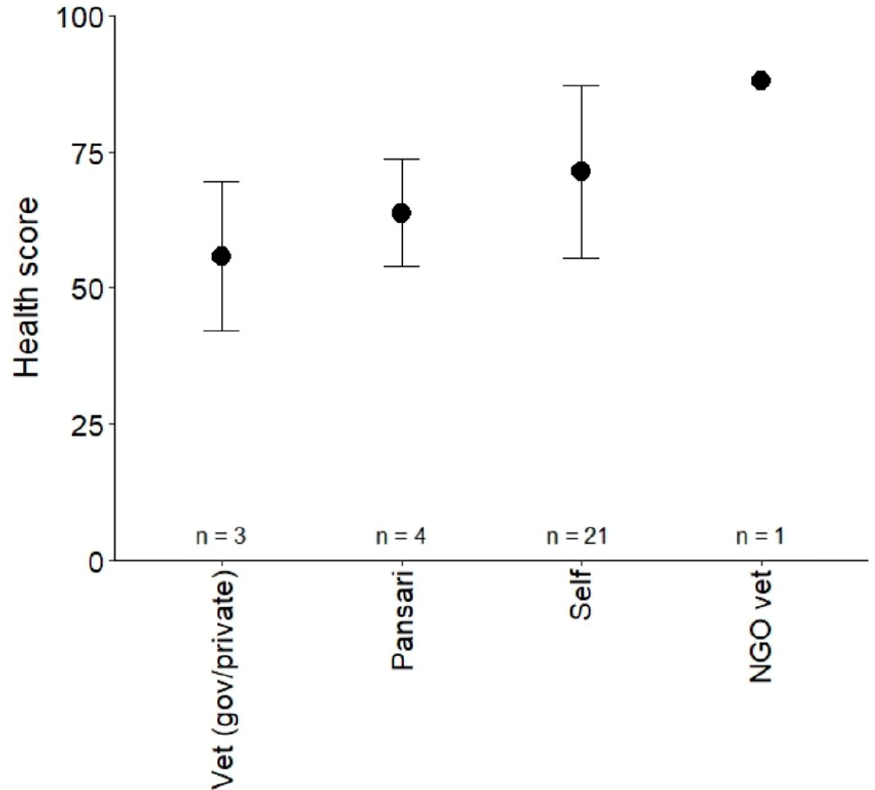
Figure 3. Mean equid health score for equid owners who selected each primary treatment type. The heath score represents welfare in terms of signs of illness, coat health, respiratory health, and skin system alterations, from 0 (worst welfare) to 100 (best welfare). Error bars represent one standard deviation from the mean.